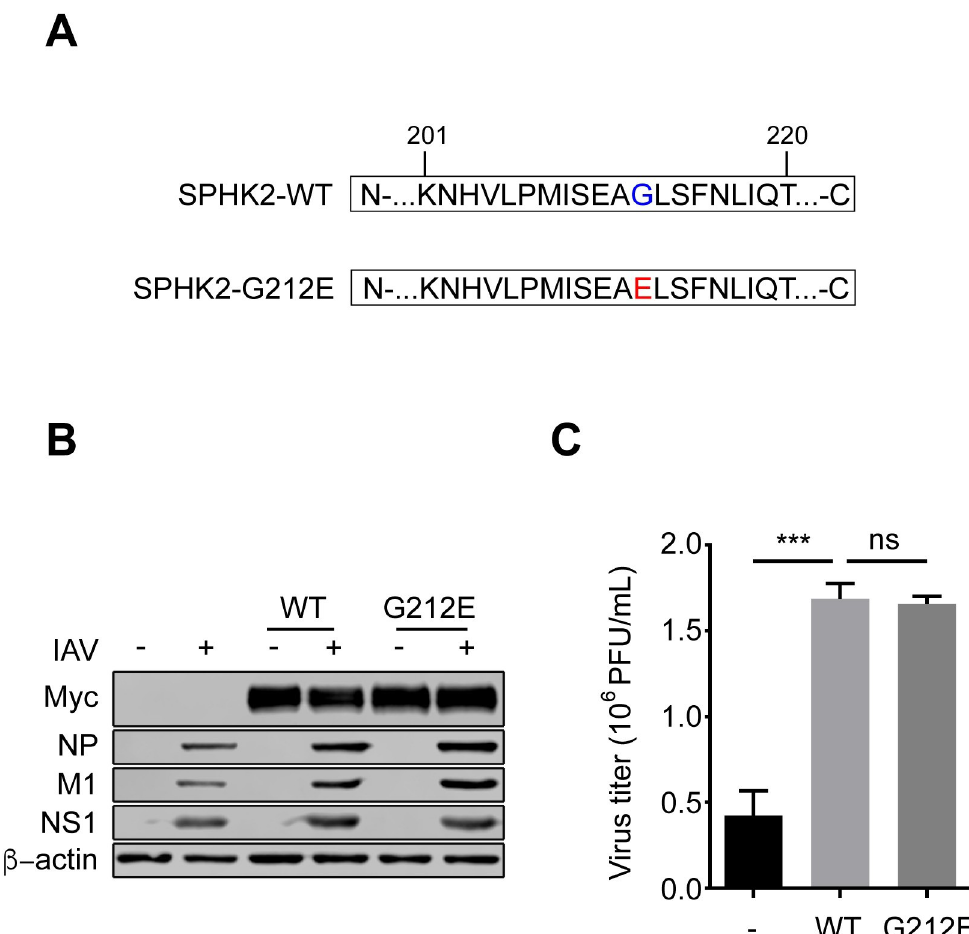
Fig 5. IAV replication is independent of the enzymatic activity of SPHK2. ( A ) The amino acid sequence of SPHK2 wild- type (WT) and the mutation site of SPHK2-G212E are indicated. ( B and C ) A549 cells were transfected with vectors encoding Myc-tagged SPHK2-WT or SPHK2-G212E mutants, pCMV-Myc plasmid was as a control vector (-), and infected with WSN virus at an MOI of 0.5. After 24 h, Western blotting was used to detected the NP, M1 and NS1 protein (B). After 24 h infection, cell supernatants were collected for a plaque assay to measure the virus titers in A549 cells at each condition (C). All data are representative of three independent experiments showing similar results. ns, no significance; ��� , P <